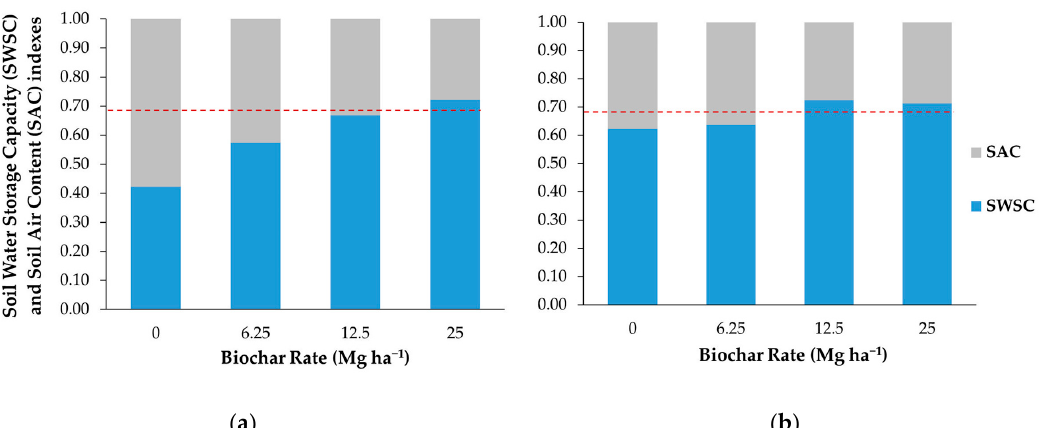
Figure 5. Soil Water Storage Capacity ( SWSC ) and Soil Air Content ( SAC ) indexes for biochar rates (0, 6.25, 12.5, and 25 Mg ha − 1 ) evaluated at ( a ) 50 days and ( b ) 150 days after incorporation in soil. Dashed red lines indicate the critical limit of water and air storage ratio to root growth (ideal ratio = SAC : 0.33 and SWSC : 0.66, as proposed by Reynolds et al. [35]).